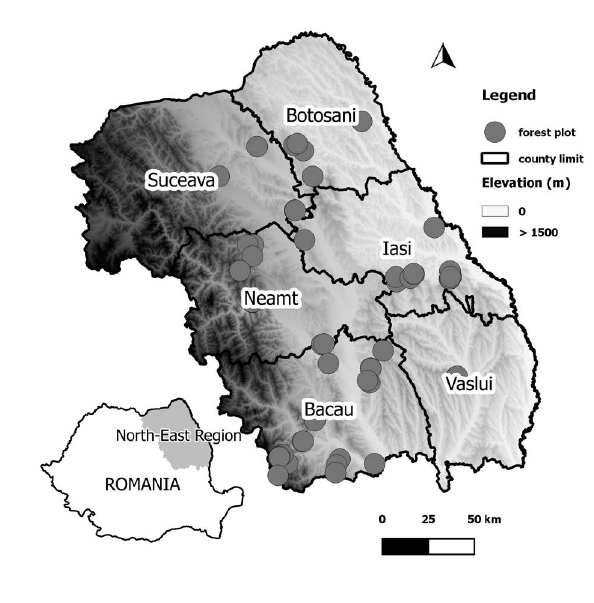
Figure 1 – Map presenting the distribution of plots in the forests from the North-East Region of